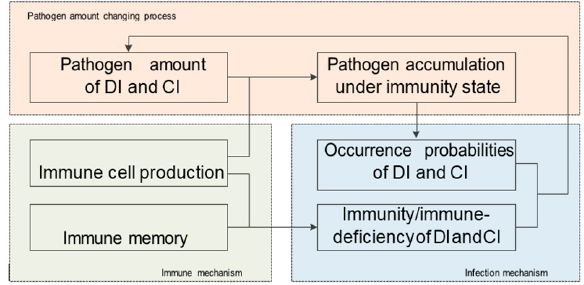
Figure 3. The relationships among the six sub-processes in the BDIIM.